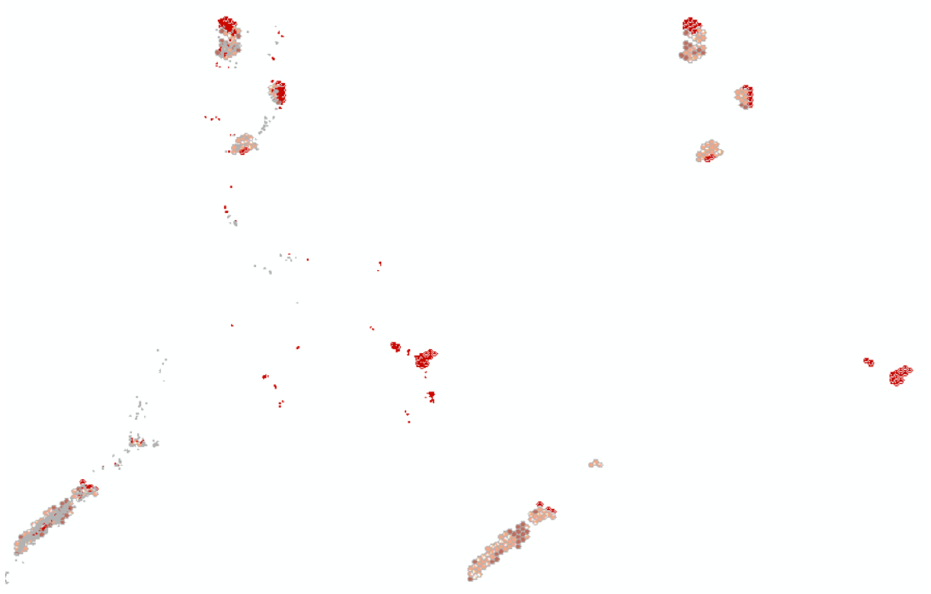
Figure A1. The comparison between 1 km ( left ) and 10 km ( right ) spatial sizes of hotspots. Spatial detail and local hotspots are preserved in the former which is suited for local enforcement of forest protection activities.